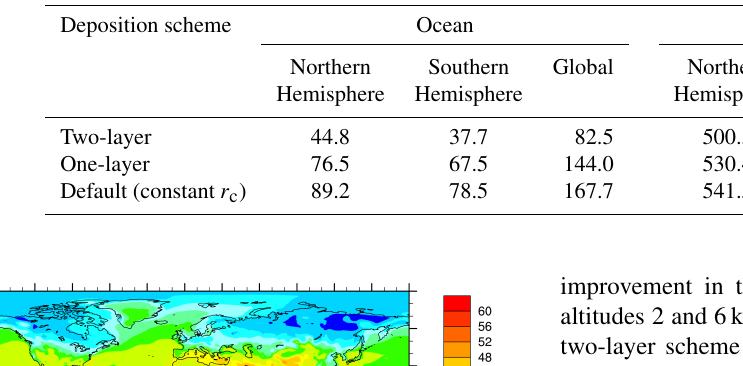
Table 2. Modelled ozone dry deposition for the year 2006 (Tgyr − 1 ).